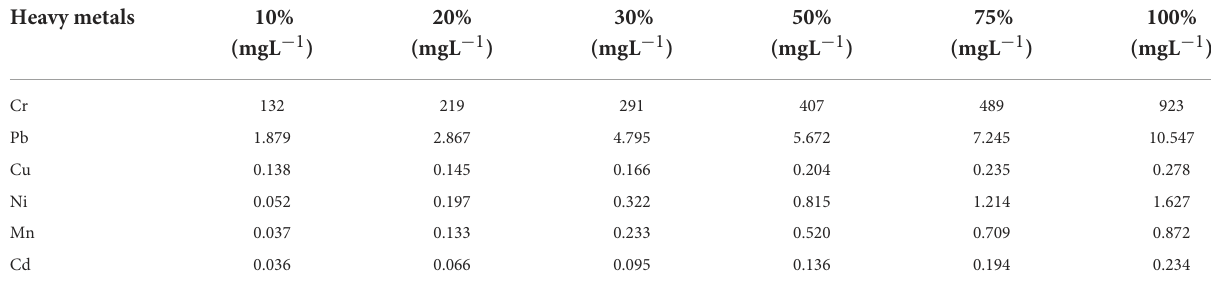
TABLE 1 Heavy metals concentration in Tannery’s